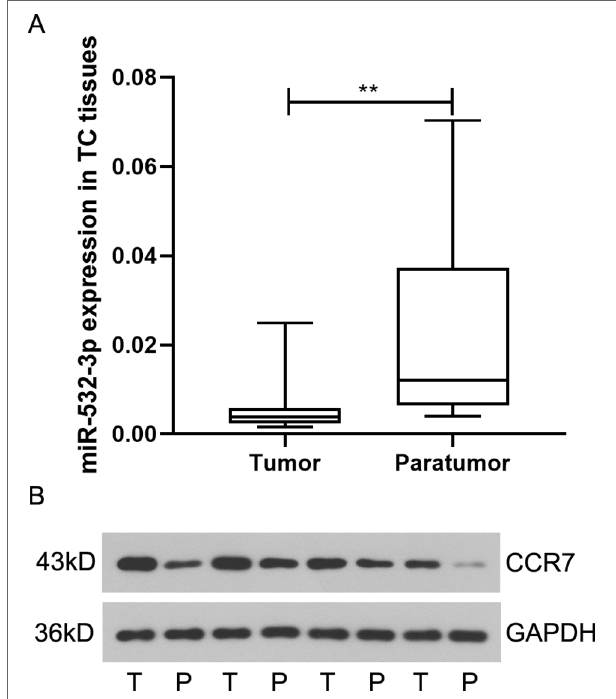
FIGURE 1 | MiR-532-3p is down-regulated in tongue cancer (TC). (A) Expression of miR-532-3p in paired TC tissues and paratumor tissues (n = 23). (B) Western blot analysis of CCR7 in paired TC tissues and paratumor tissues. ** means p <